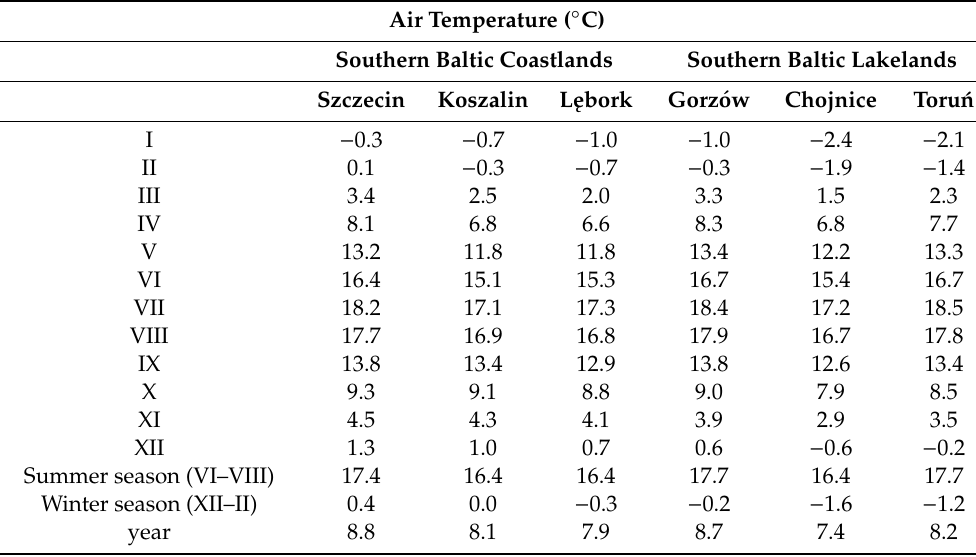
Table 2. Average monthly, semi-annual and annual values of air temperatures ( ◦ C) in the studied stations, 1952–2018 (calculated based on data obtained from the Polish Institute of Meteorology and Water Management—National Research Institute [43]).